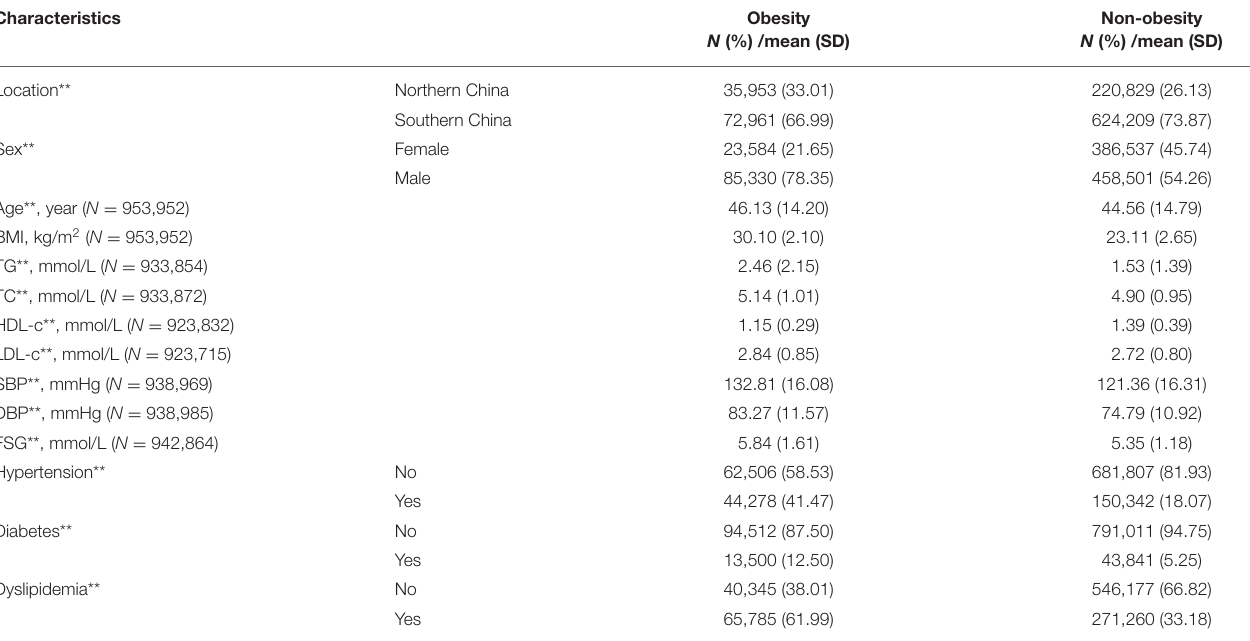
TABLE 1 | Characteristics of selected study participants by obesity status.